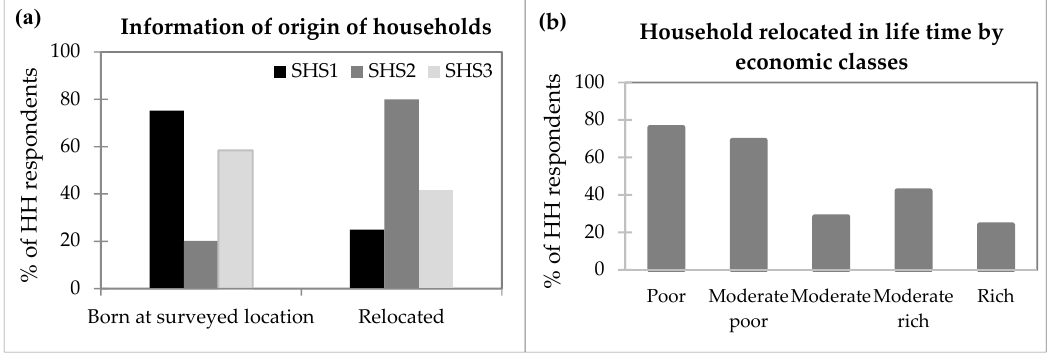
Figure 5. Households relocated due to riverbank erosion. ( a ) Information of origin of households. ( b ) Household relocated in lifetime by economic classes.